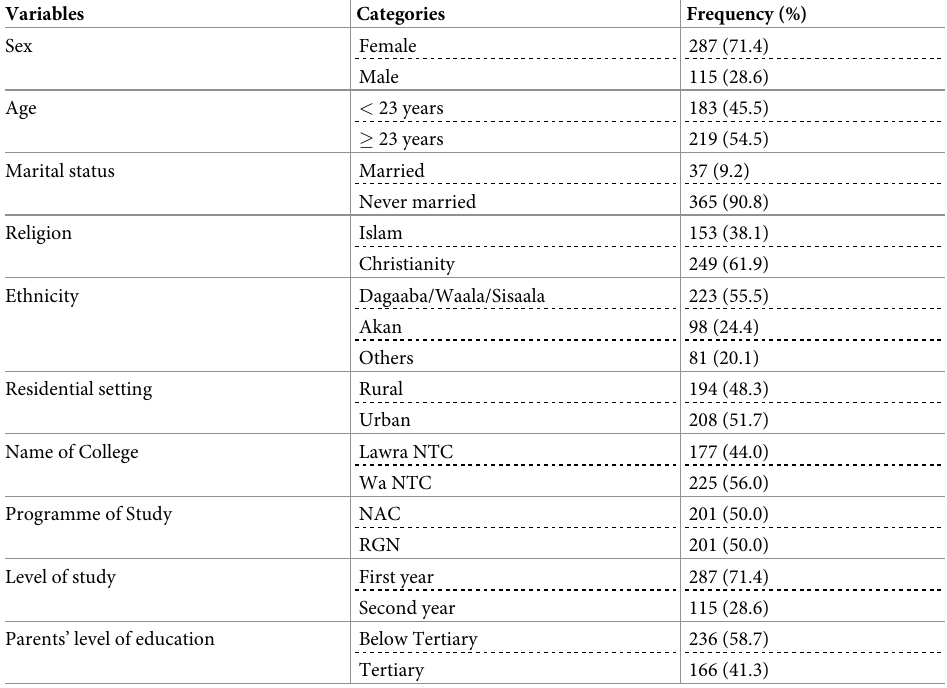
Table 1. Socio-demographic characteristics of the nursing students (n =